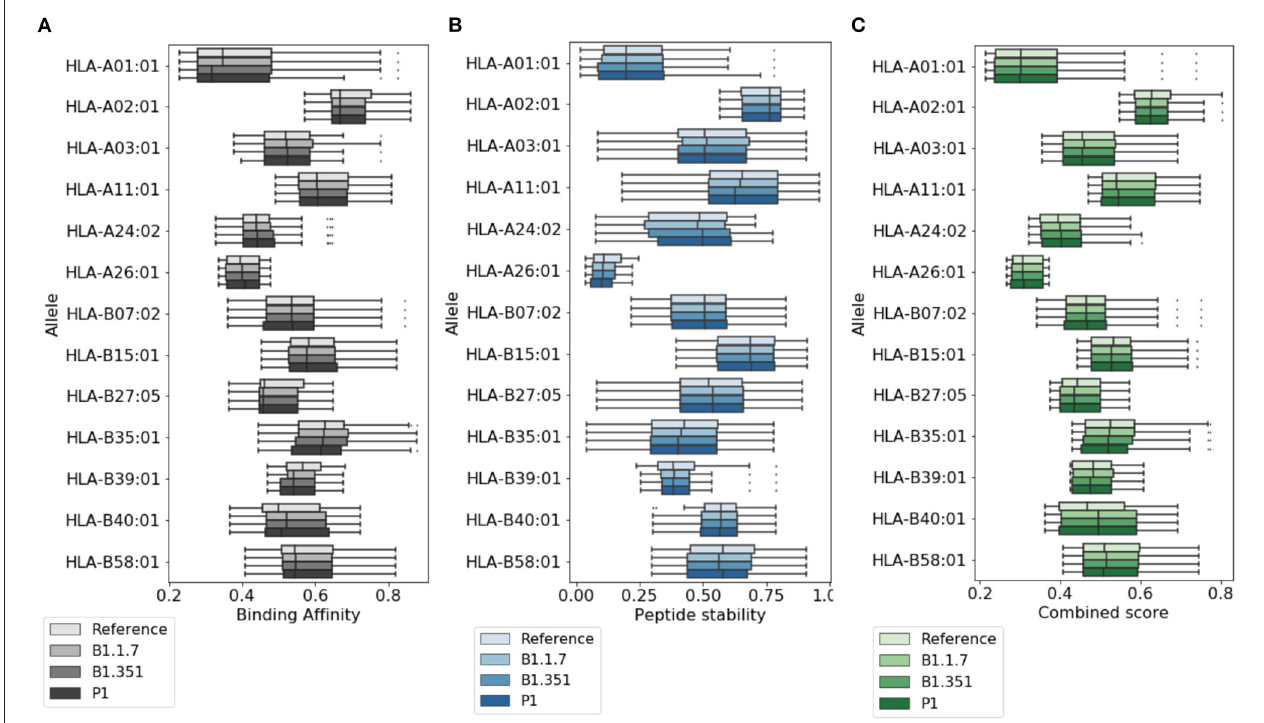
FIGURE 2 | Variations of T cell epitope properties in virus variants. For the highly ranked peptides selected by NetTepi we report the boxplots for (A) binding affinity, (B) peptide stability, and (C) the combined score also including T cell propensity. Data are reported for different virus variants and alleles.